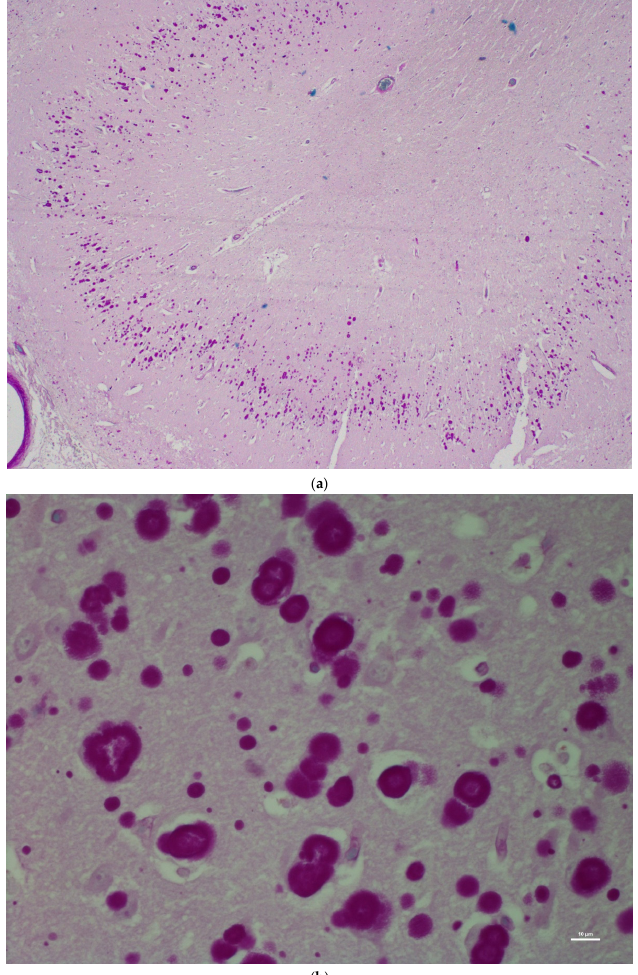
Figure 4. ( a ) Low magnification (2x) showing a diastase-digested periodic acid-Schiff (PASD) section of the hippocampus of the same moose showing polyglucosan (Lafora) bodies; ( b ) higher magnifica- tion showing a diastase-digested periodic acid-Schiff (PASD) section of the hippocampus of the same moose showing polyglucosan (Lafora)